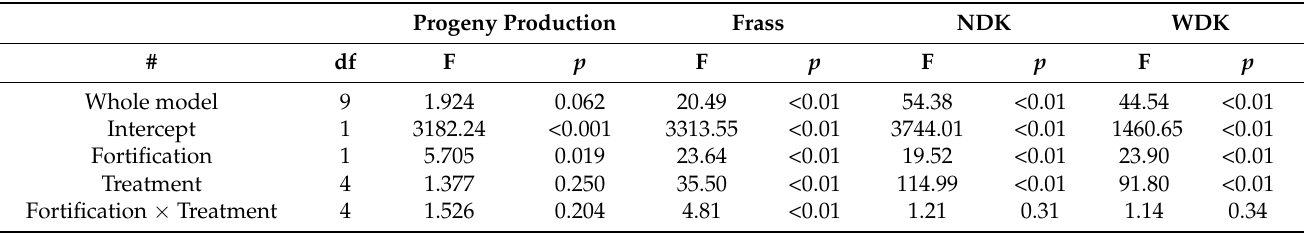
Table 2. ANOVA parameters for population growth of Rhyzopertha dominica and quality parameters (frass, number of damaged kernels (NDK) and weight of damaged kernels (WDK)) in vials that contained rice fortified with spearmint or basil at 0, 25, 50, 75 and 100% (total df = 70). Progeny Production Frass NDK